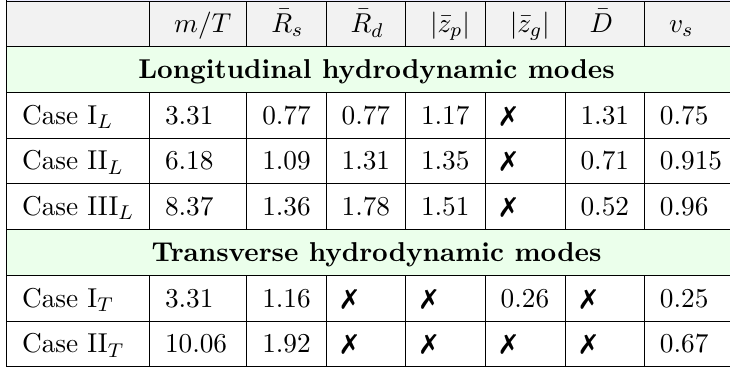
JHEP11(2022)032